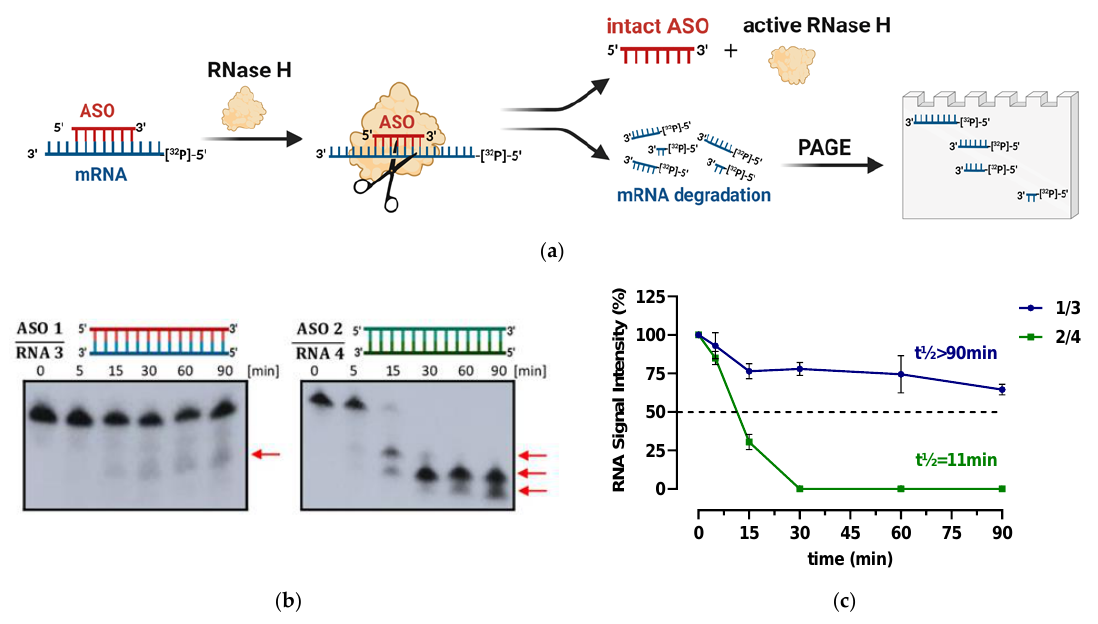
Figure 1. Representative illustration of hybridization of ASO (DNA) with mRNA targets and re- cruitment of the DNA/RNA heteroduplex by RNase H, which cleaves the mRNA targets (panel a ). Autoradiograms of 20% denaturing PAGE, showing the cleavage time course of 5′ -[ 32 P]-labelled RNA 3 or RNA 4 in the duplexes 1 / 3 or 2 / 4 containing ASO 1 or ASO 2 (panel b ) after treatment with RNase H (1 µL of 0.3 U/µL stock solution) at 0, 5, 15, 30, 60, and 90 min. Densitometric analyses of the intact 5′ -[ 32 P]-RNA substrates were performed using three independent PAGE analysis exper- iments (panel c ) and degradation half-lives were calculated based on signal intensity for RNA 3 and for RNA 4 . The red arrows in panel b show the products of degraded 5′ -[ 32 P]-RNA. Experimental conditions are described in the Materials and Methods section. Figures were created in BioRender (https://biorender.com/, accessed on 23 June 2022) and GraphPad Prism (https://www.graphpad.com/, accessed on 15 August 2022).